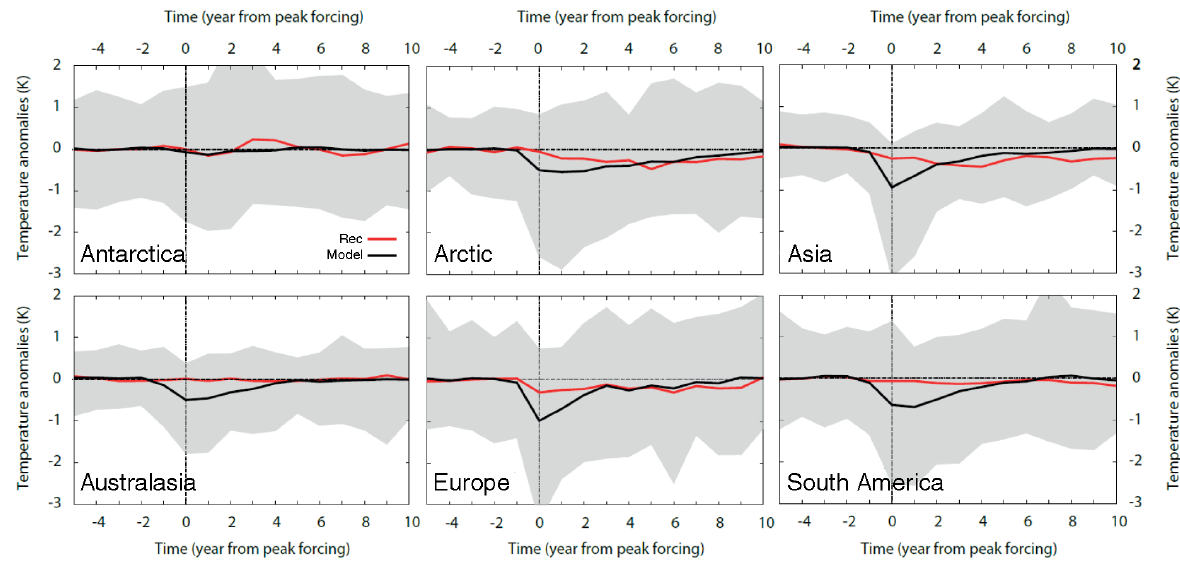
Figure 8. Superposed epoch analysis of the impact of the volcanic activity in the reconstructed and simulated temperatures. Superposed composites of temperature responses during selected periods when peak negative forcings in the Crowley and Unterman (2012) volcanic reconstruction are aligned. The composite is produced by selecting the 12 strongest volcanic events, starting 5 years before the date of the peak eruption and ending 10 years after the event. Each panel indicates the reconstructed (red lines) and simulated (black) composites of the temperature response for each PAGES 2k region. The grey shading indicates the complete range of simulated temperature